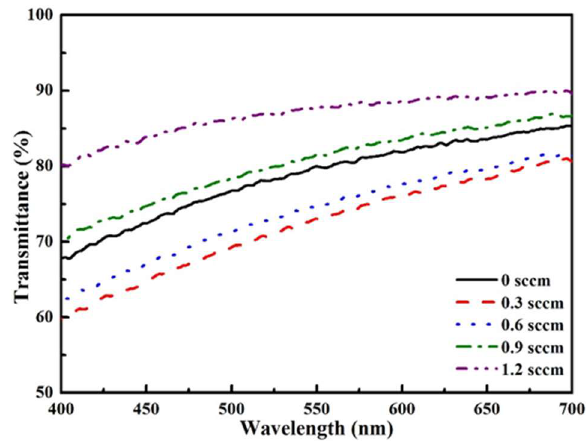
Figure 5. The transmittance spectra of SiO x :DLC films with the different HMDSO flow rates. (RF bias = 400 V, DC power = 50 W, CH 4 = 12.5 sccm, thickness = 65 ± 5 nm).